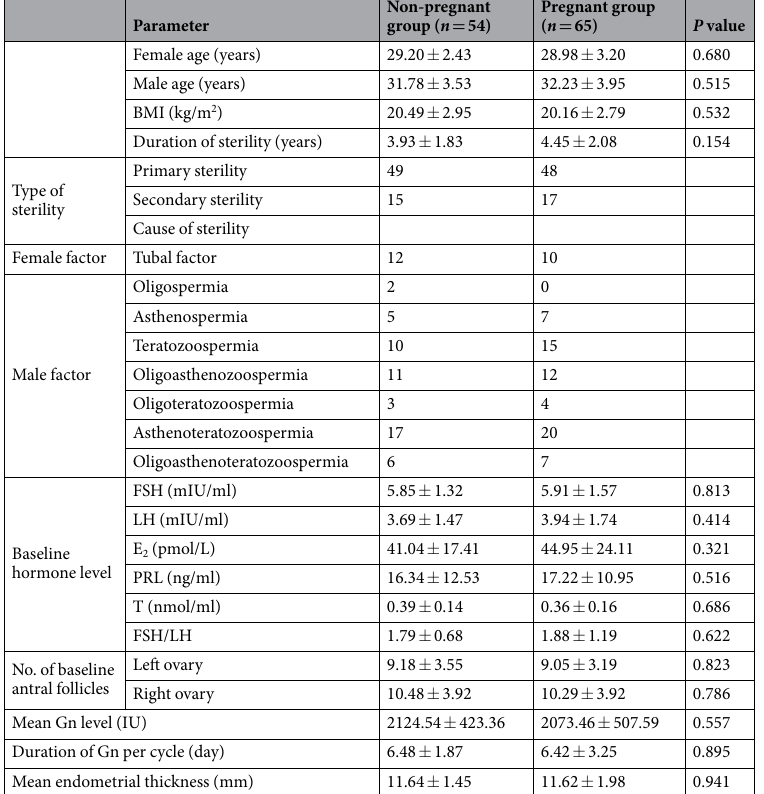
Pearson correlation analyses revealed that pregnancy correlated negatively with GOLPH3 expression ( r = − 0.946, P < 0.01) and cumulus granulosa cell apoptosis ( r = − 0.557, P < 0.01), and positively with the number of follicles punctured ( r = 0.34, P < 0.01), number of grade III oocytes ( r = 0.27,